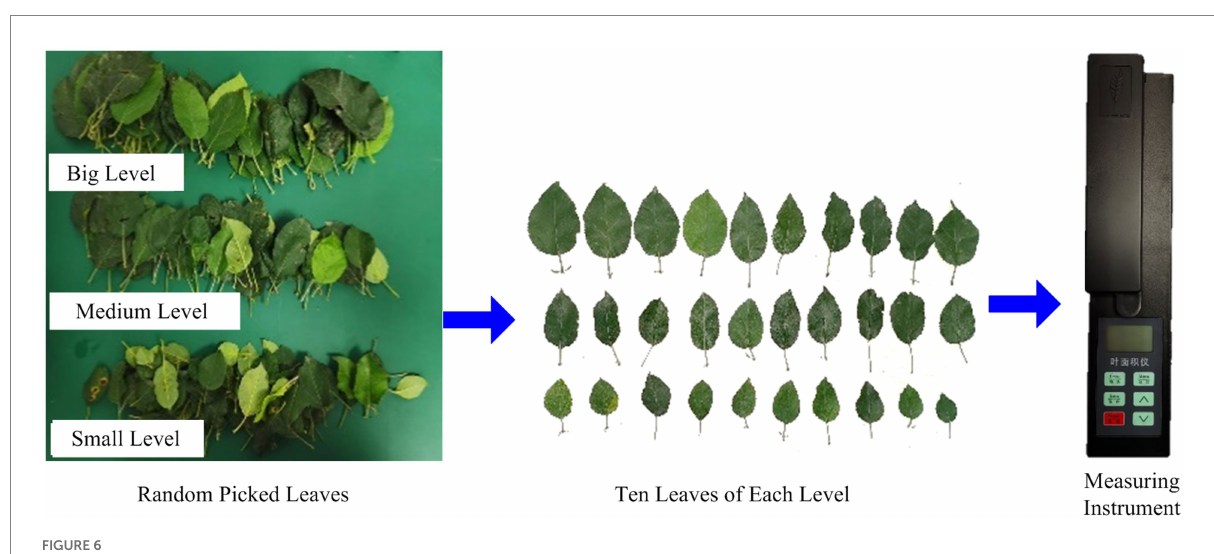
FIGURE 6 Leaf area measurement by statistical